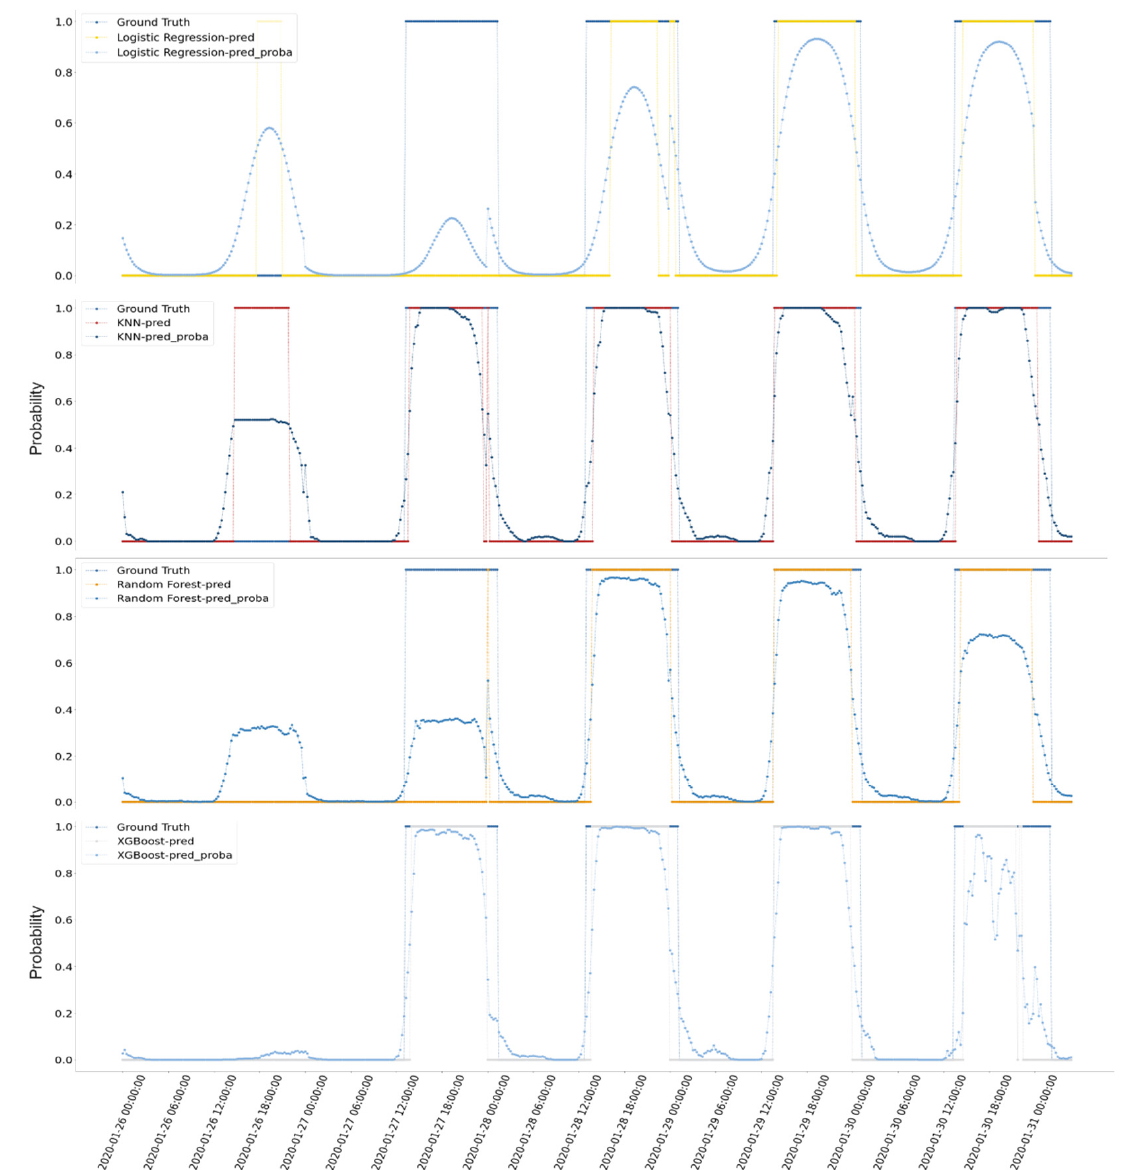
Figure 7. Forecasted occupancy probability for last week of January 2020 for one charging point at JPL based on mode ‘all’ and standard feature set.